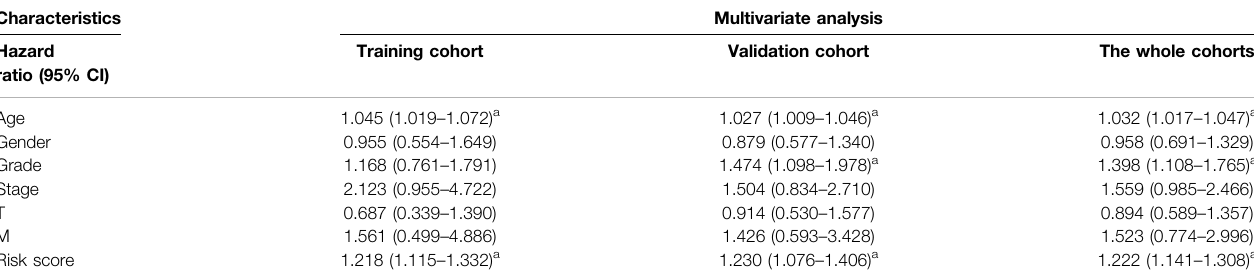
TABLE 2 | Multivariate Cox regression analysis in training, validation, and the whole